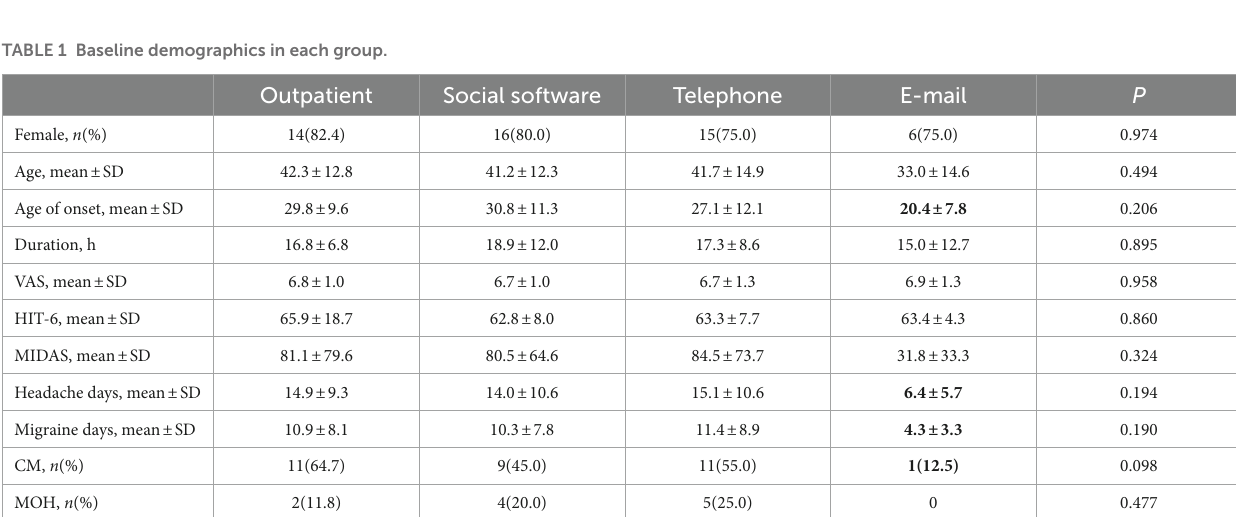
FIGURE 1 Study flow.